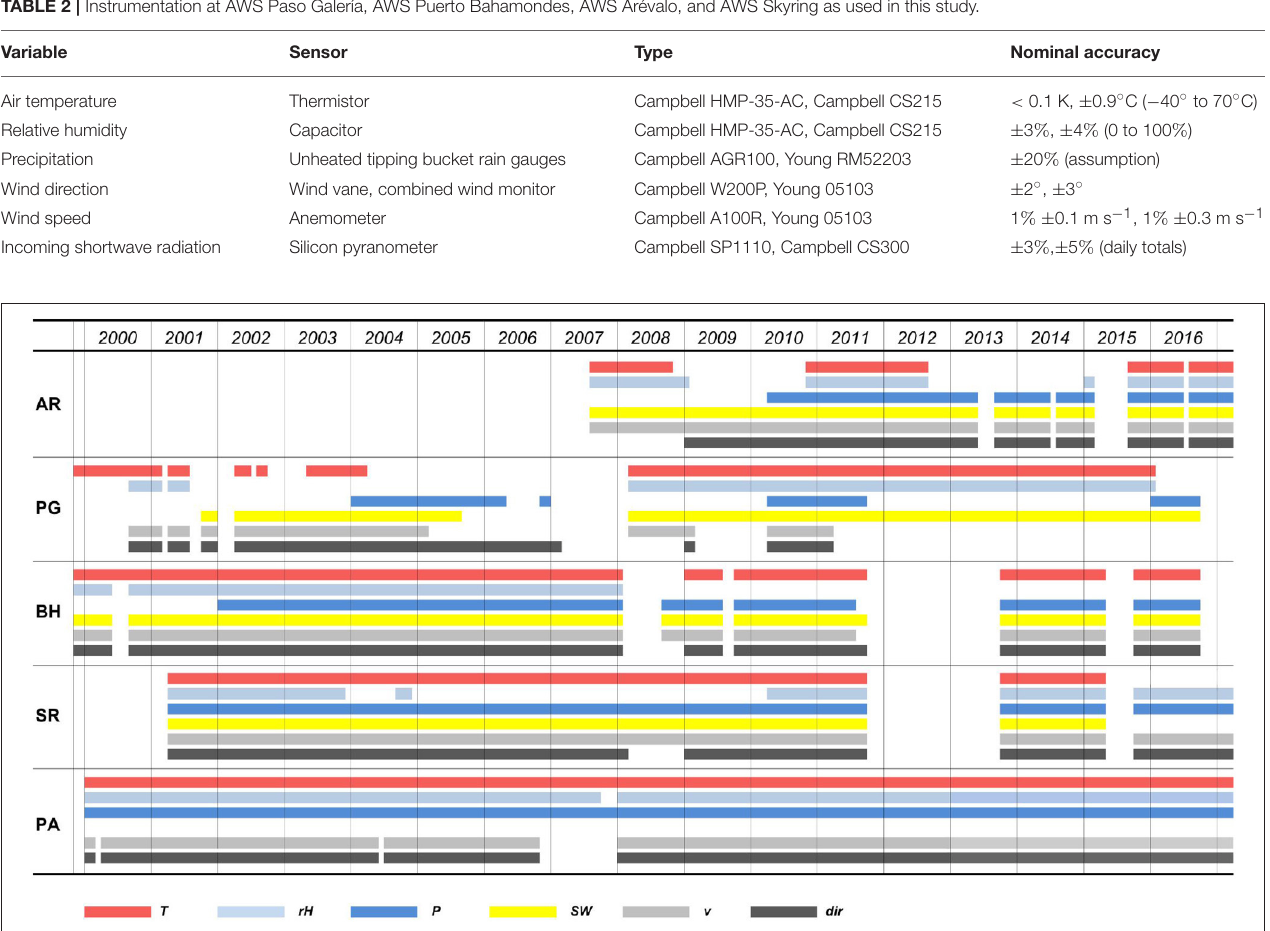
FIGURE 2 | Available observation periods at AWS Arévalo (AR), AWS Paso Galería (PG), AWS Puerto Bahamondes (BH), AWS Skyring (SR), and WS Punta Arenas (PA). Shown are measurement periods of air temperature (T), relative humidity (rH), precipitation (P), incoming shortwave radiation (SW), wind speed (v), and direction